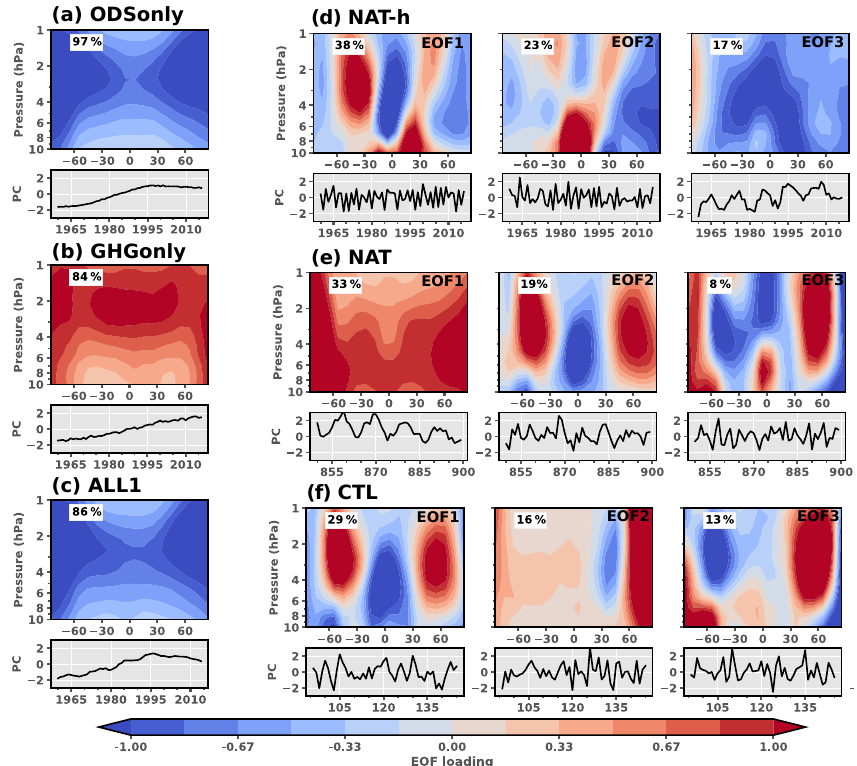
Figure 5. Leading signal and natural variability modes for upper-stratospheric ozone in WACCM. The signal modes are the leading EOFs of the ensemble mean anomalies from GHGonly, ODSonly, and ALL1 calculated over 1960–2016 for GHGonly and ODSonly and over 1960– 2014 for ALL1. The leading natural variability modes are EOFs 1, 2, and 3 of the NAT, NAT-h, and CTL. The percentage variance explained by each mode is given in the upper left corner of the EOF. For NAT-h the EOFs were calculated from the ensemble-mean anomalies for the period 1960–2016. The total lengths of the NAT and CTL simulations are 1000 and 200 years, respectively. Recall that NAT-h is defined by subtraction (see Sect.